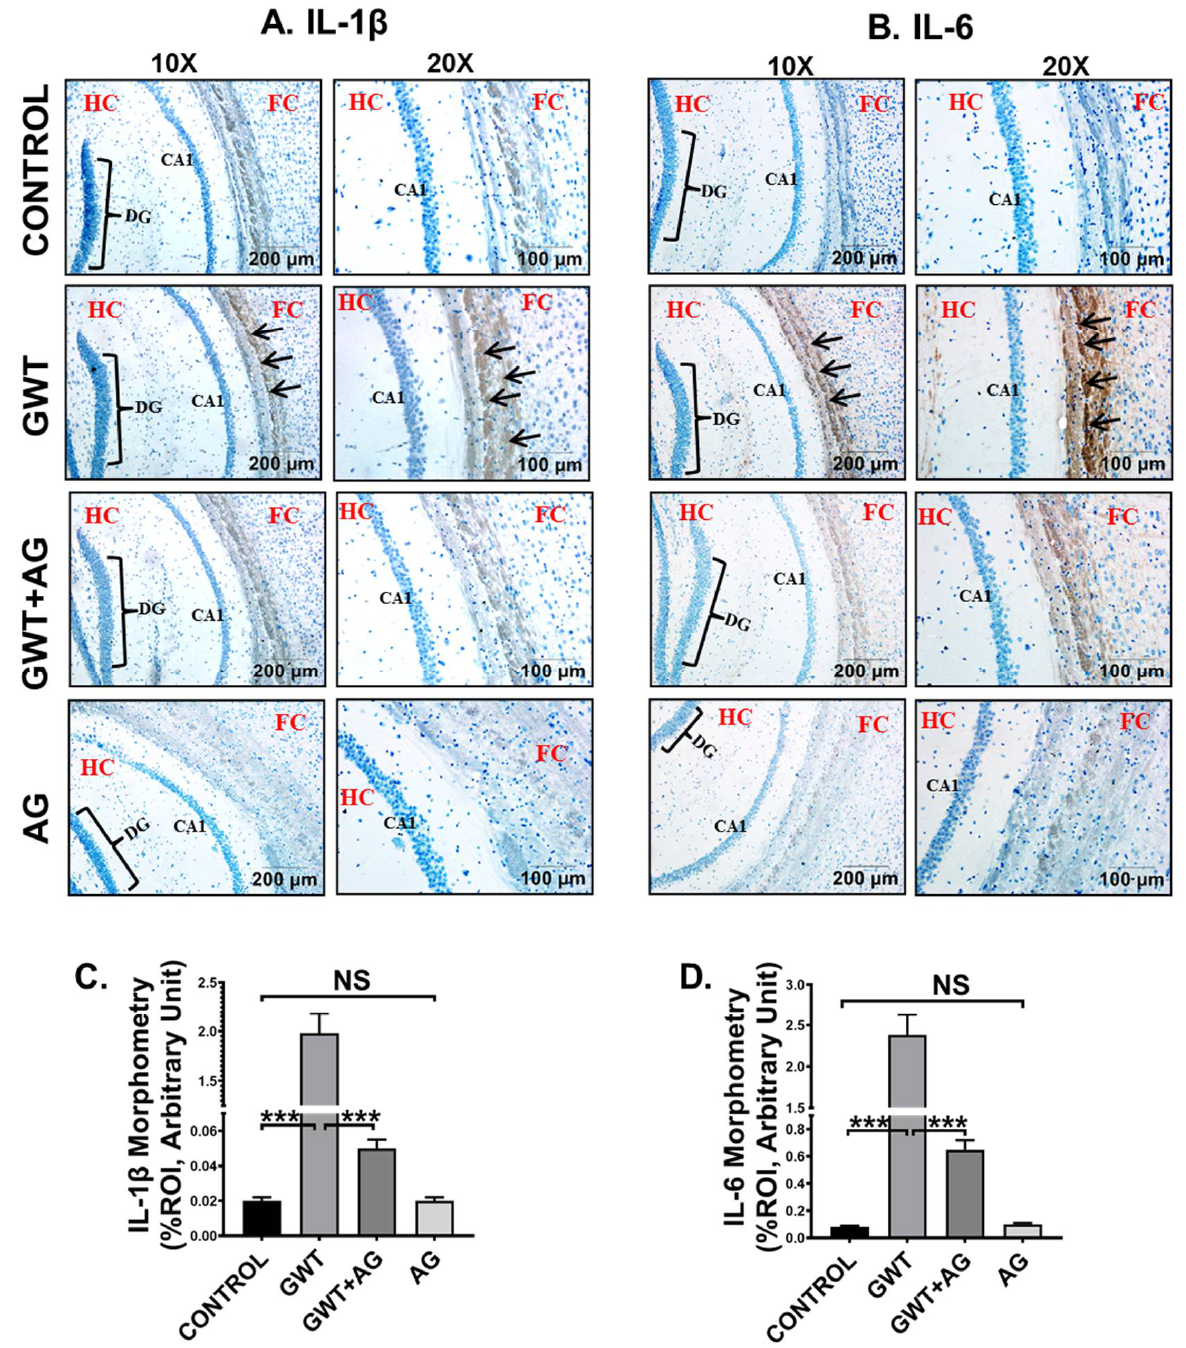
Figure 8. AG administration in GW chemical-treated mice decreases neuroinflammation. Representative immunohisto- chemistry images of ( A ) IL-1 β and ( B ) IL-6 immunoreactivity in the brain sections of CONTROL, GWT, GWT+AG, and AG mice groups. Images were captured in 10 × and 20 × magnification, and immunoreactivity was indicated by black arrows. The Hippocampus region is marked as HC, the dentate gyrus area is marked as DG, the cornu ammonis area is marked as CA1, whereas the frontal cortex is marked as FC. Morphometric analysis (calculated as %ROI) of ( C ) IL-1 β and ( D ) IL-6 immunoreactivity. Y -axis represents % positive immunoreactive area (% ROI) ( n = 3; mean value taken from three separate microscopic fields) (*** p < 0.001, NS: non-significant). Data were represented as mean ± SEM and statistical significance was tested using unpaired t -test between the groups (* p < 0.05, ** p < 0.01, *** p < 0.001), followed by Bonferroni Dunn Post hoc corrections.